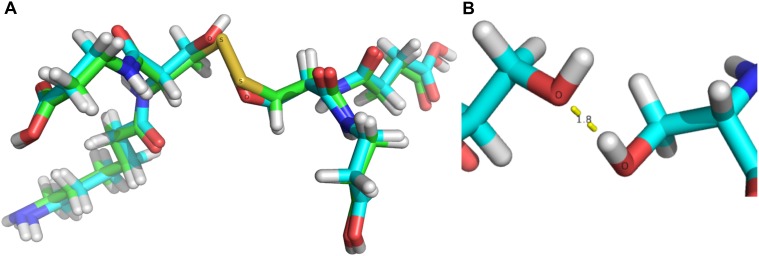
Computational analysis of the C77-105S mutation.(A) Superposition of geometrically optimized structures of the natural disulfide bond and the C77-105S mutation. (B) Formation of a new hydrogen bond in the C77-105S mutant.